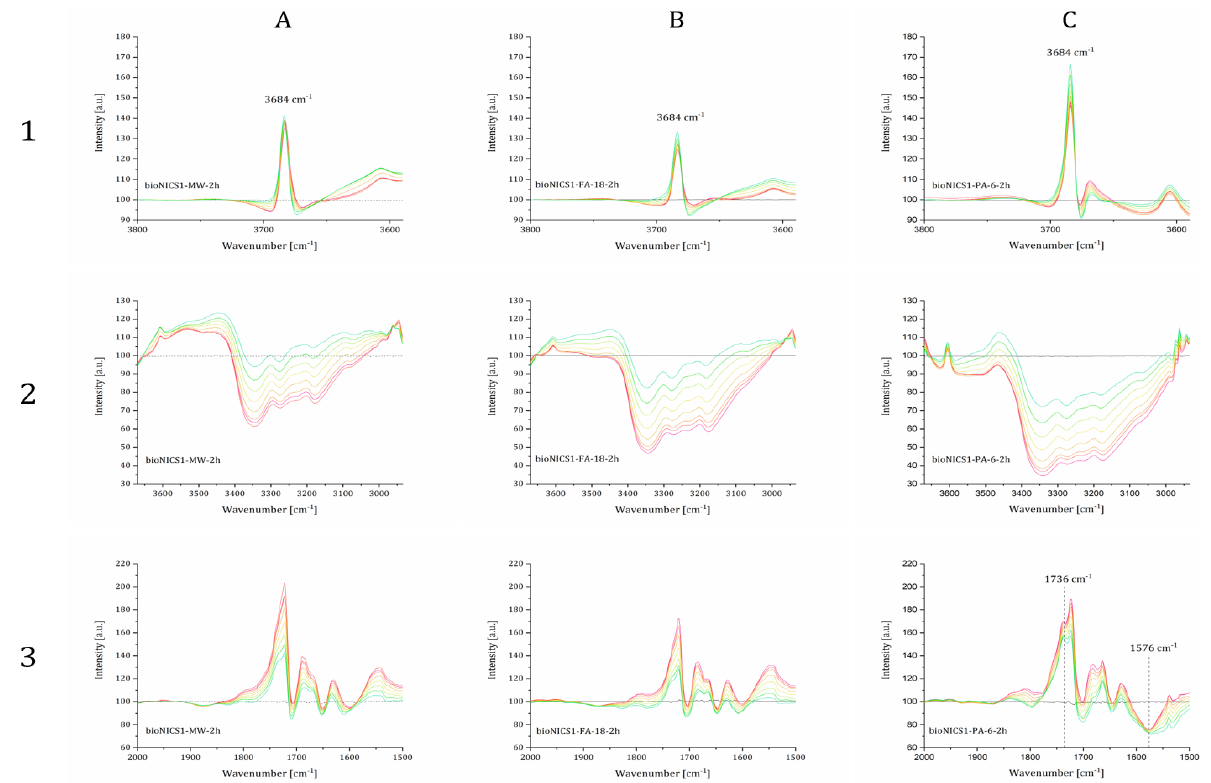
Figure 6. DRIFTS spectra of the specified samples purged with 10 % NH 3 in Ar measured from room temperature (red lines) to 150 °C (green lines) shown in three wavenumber regions. Black lines represent the baseline of the activated materials. Represented samples are bioNICS1-MW-2h ( A ), bioNICS1-FA-18-2h ( B ) and bioNICS1-PA-6-2h ( C ).